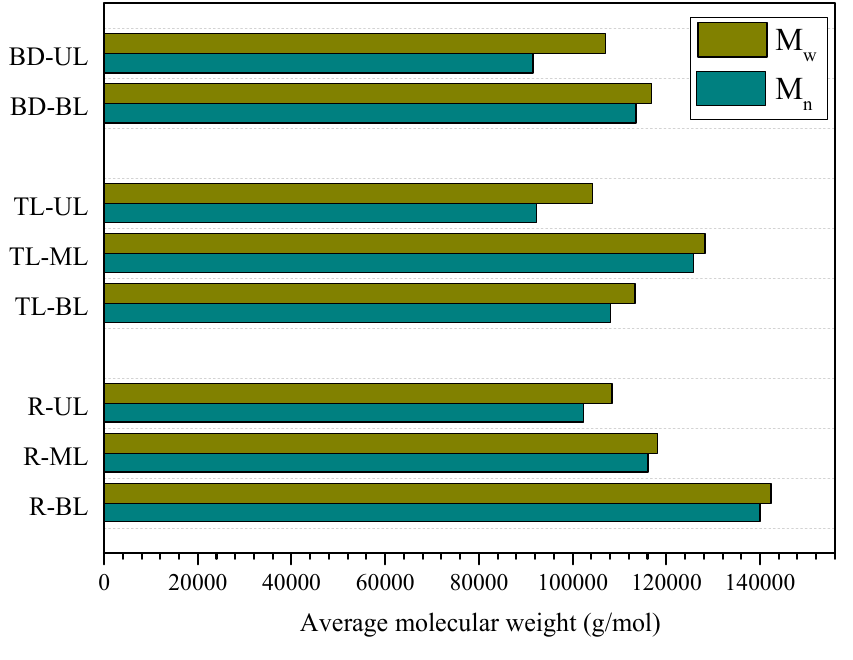
Figure 2. The M w and M n of bitumen after aging. 118